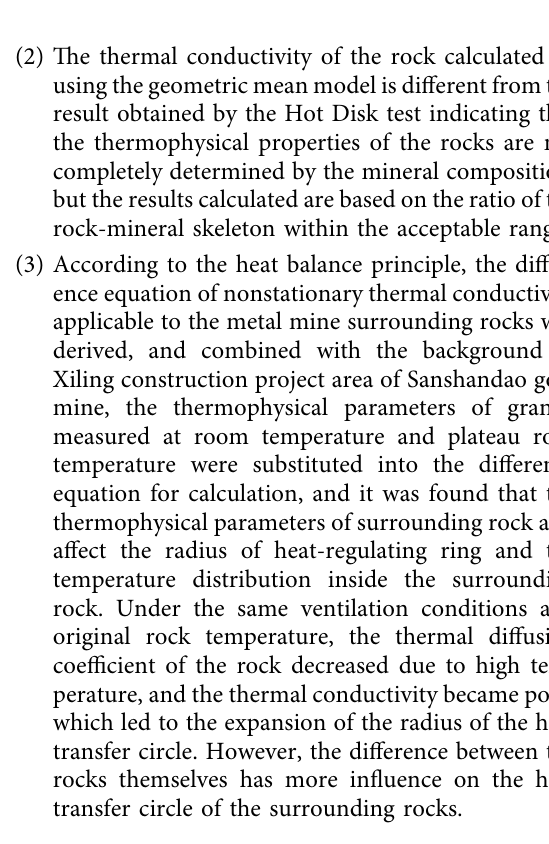
Figure 6: Comparison of changes in the radius of the heat transfer zone of the surrounding rock in different depths of rock